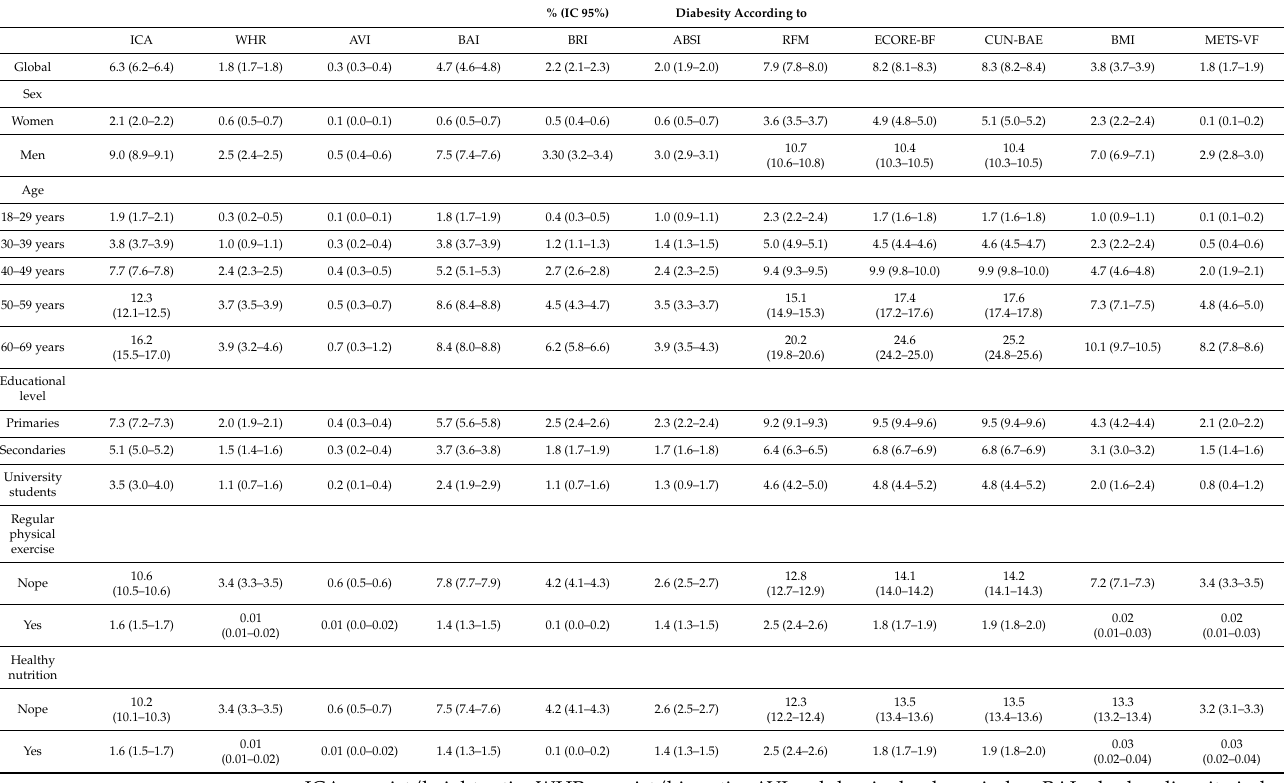
Table 3. Prevalence of diabesity according to the formula used and for the different study variables.